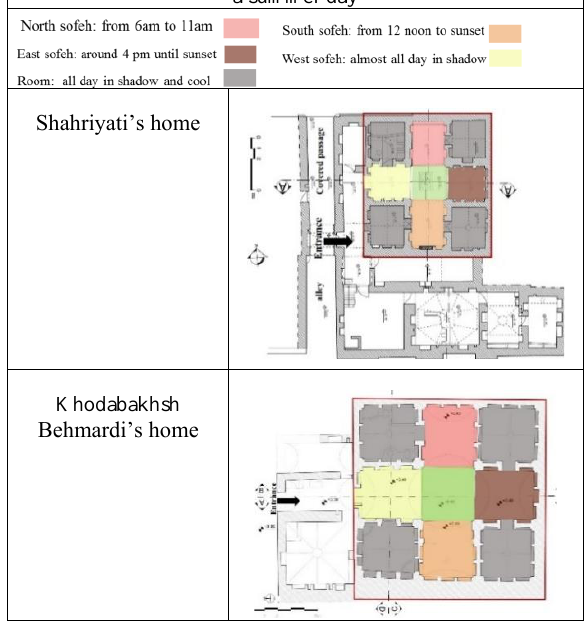
Table 4. Performance of home spaces due to sun circulation on a summer day.